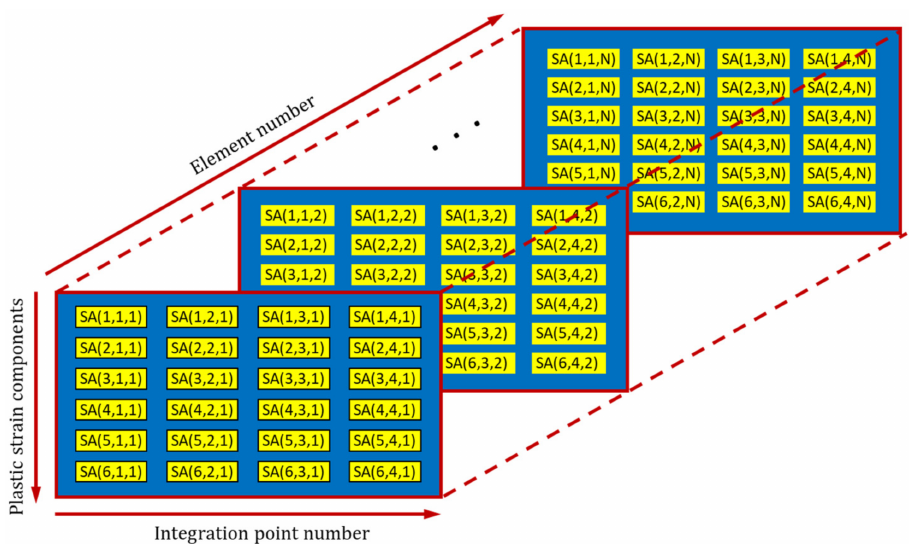
Figure 7. The data structure of plastic strain tensor at the integration points of all